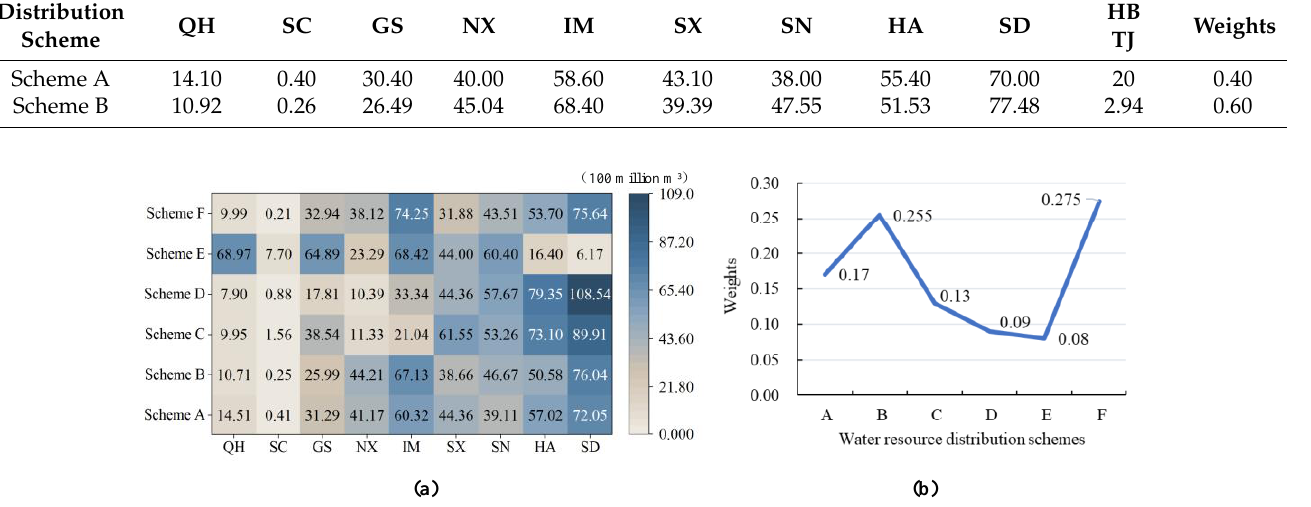
Figure 7. Results of the Yellow River water distribution scheme with 37 billion m 3 of water.